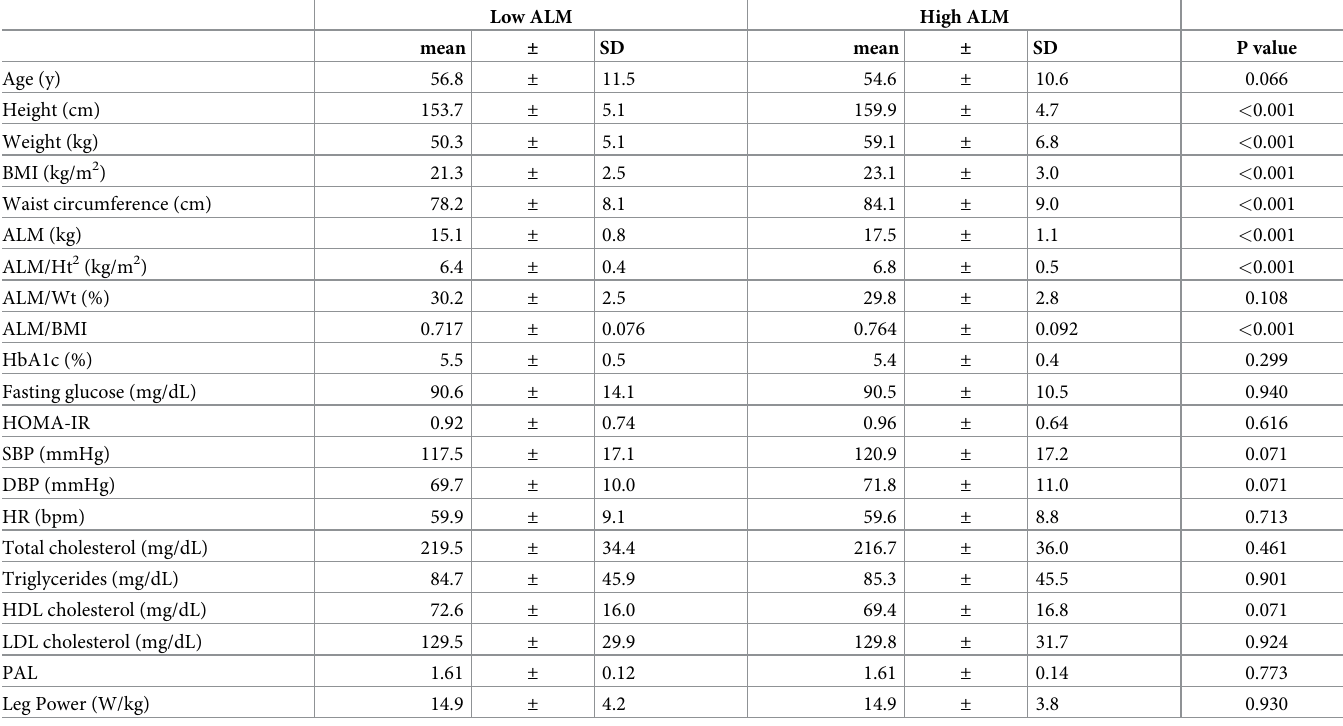
Table 1. Baseline characteristics of the study participants according to absolute ALM (N =